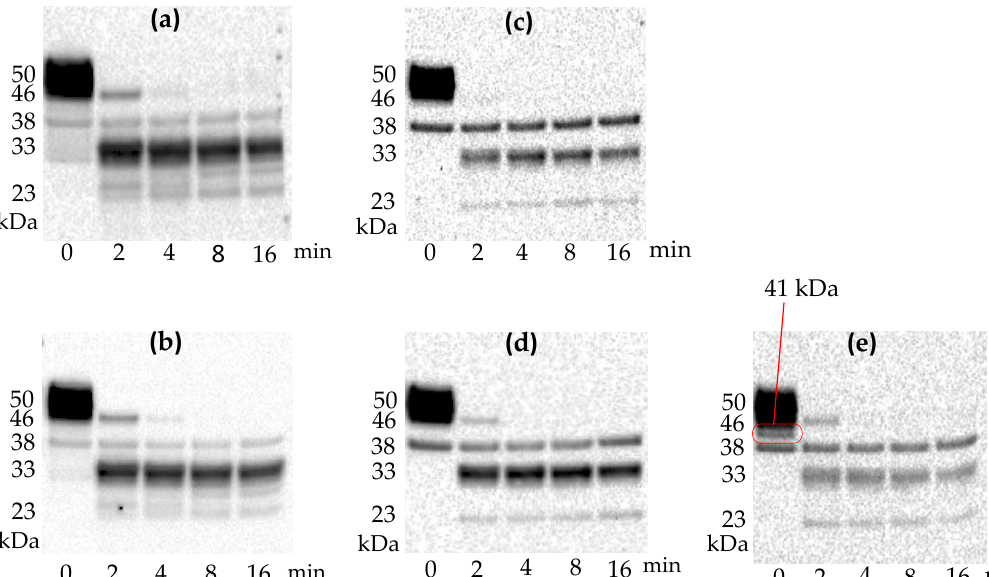
Figure 1. Western blot analysis of undigested flagellin and trypsin-digested flagellin fragments. Flagellin was incubated with trypsin at a protein ratio of 10:1 ( w / w ) for 2, 4, 8, and 16 min at room temperature. Five different anti-flagellin antibodies, ( a ) MAb 1C8, ( b ) MAb 7E3, ( c ) MAb 3H8, ( d ) MAb 5F11 and ( e ) MAb 1E10 were used to detect the flagellin and its fragments. Precision Plus Protein™ WesternC™ Standards were used for the molecular weight calibrations.